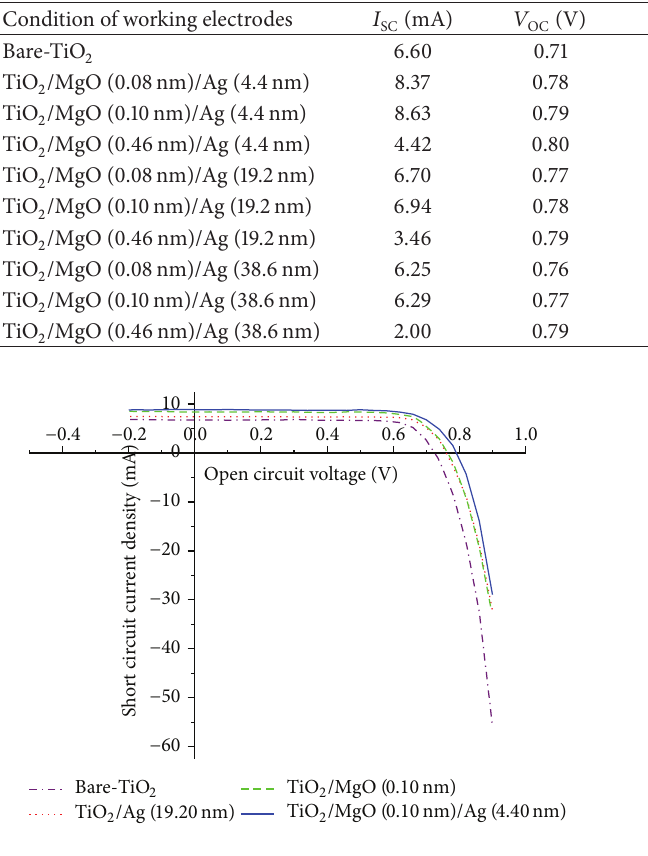
Figure 12: Comparison of the efficiencies of DSSCs with different types of electrodes, that is, the bare-TiO 2 , TiO 2 /Ag (19.2 nm), TiO 2 /MgO (0.10nm), and TiO 2 /MgO (0.10nm)/Ag (4.4nm) elec- trodes.